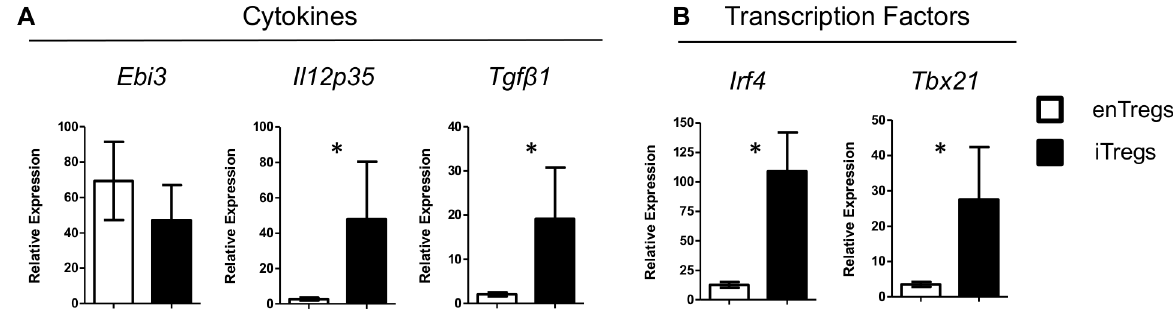
Figure 4. Comparison of cytokines and transcription factors expressed by enTregs and iTregs. mRNA was isolated from enTregs and iTregs that were transferred into TxA23 mice, analyzed by qRT-PCR and normalized to mRNA isolated from CD4 + Foxp3 - T cells from BALB/c mice. ( A ) Comparison of expression levels of cytokines IL-35 ( Ebi3 and Il12p35 ) and Tgf b 1 . ( B ) Comparison of expression levels of transcription factors Irf4 and Tbx21 (Tbet). Data shown as mean 6 SEM from 4-6 independent experiments and analyzed using a Mann–Whitney U test. * p , 0.05.